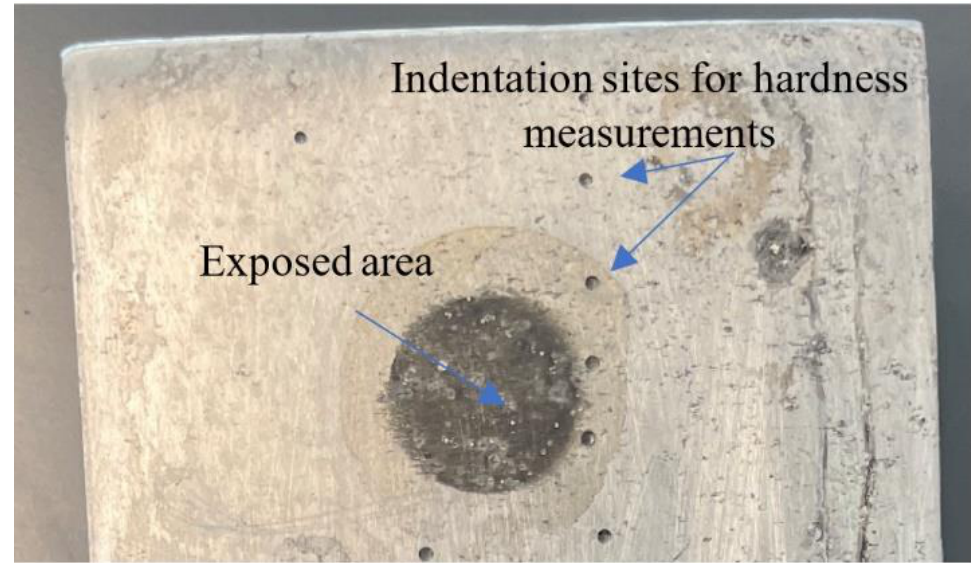
Figure 4. Indentation sites and exposed area of the water-quenched part of the block.